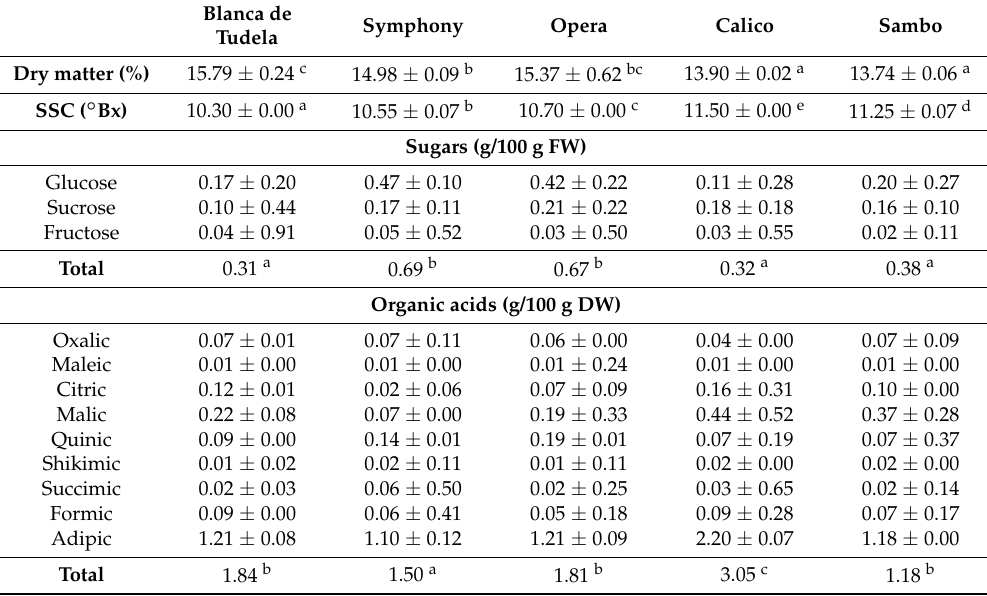
Table 1. Basic chemical composition of artichoke